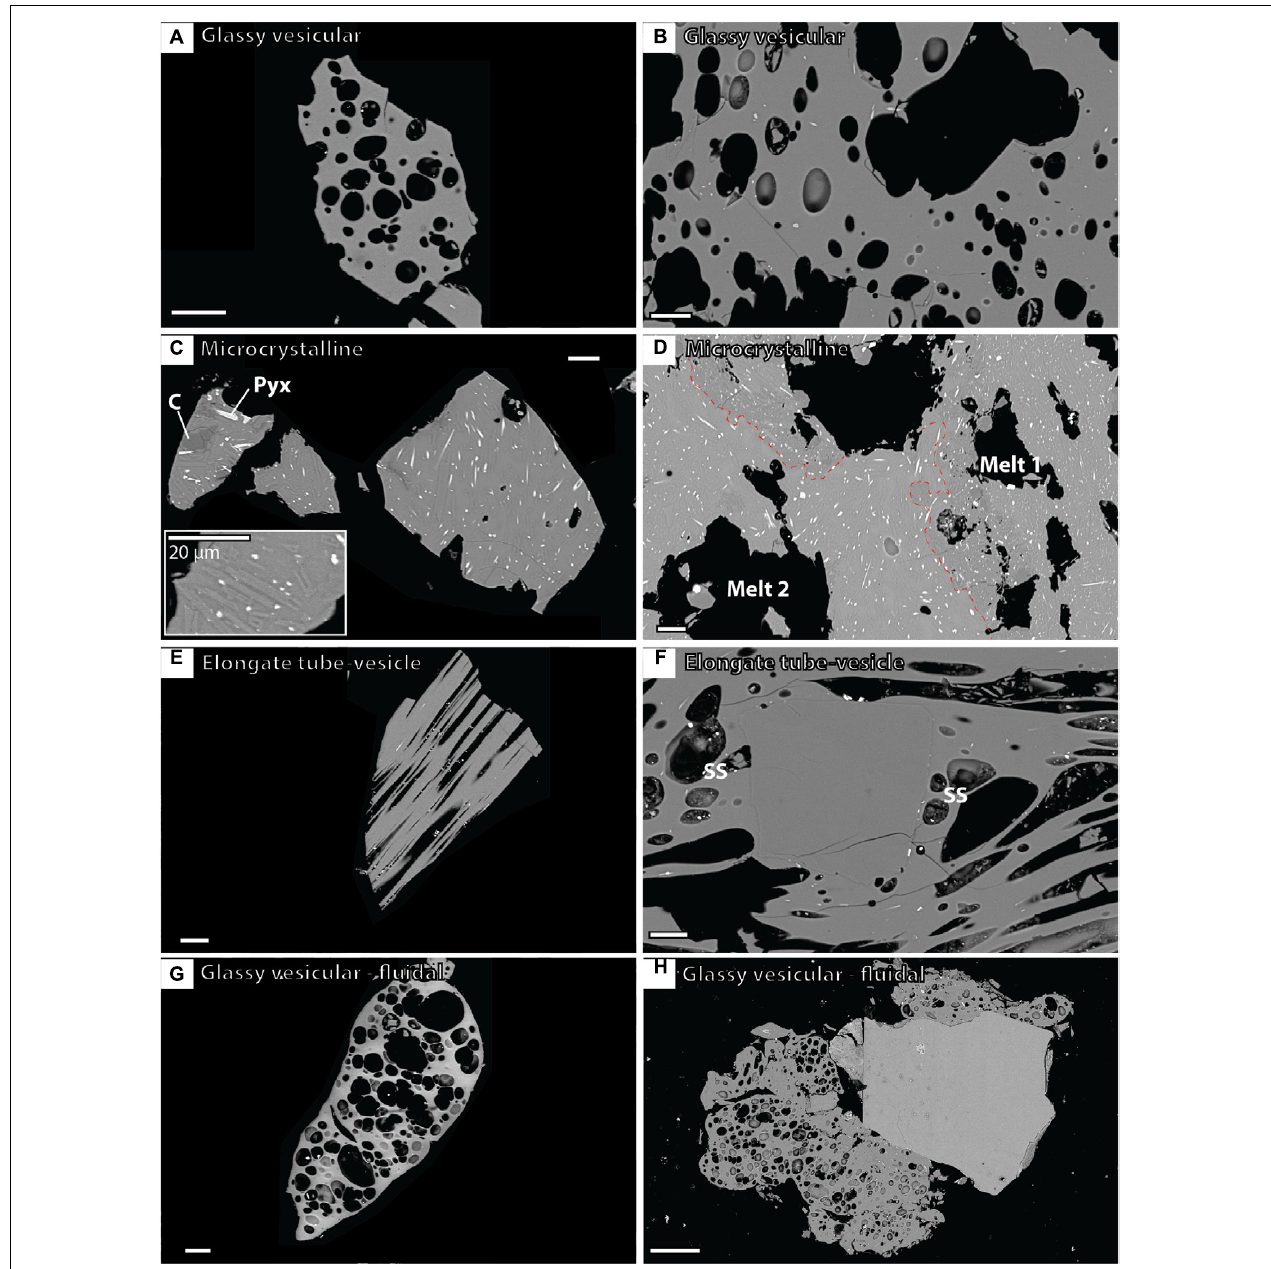
FIGURE 9 | SEM images illustrating representative microtextures of glassy vesicular (a,b) , microcrystalline (c,d) , elongate tube-vesicle (e,f) , and glassy vesicular fluidal (g,h) components (scale bars are 100 µ m unless otherwise noted). Glassy vesicular particles show rounded vesicles and dominantly glassy groundmasses. Microcrystalline particles show a range of both groundmass crystallinity and vesicle textures (c,d) , in (c) three microcrystalline grains can be observed each showing differing crystallinities show plagioclase (Plg) and pyroxene (Pyx) microlites. Groundmass-hosted cristobalite (C) is common (c) , textures of mingling between melt of different crystallinities are rarely observed (d) . Elongate tube-vesicle grains are generally glassy with aligned sheared vesicles and microlites (e,f) . Around phenocrysts strain shadows (SS) can occasionally be observed (f) . The fluidal particles show a Pele’s Tear-like structure with a highly vesicular core and a dense glassy rim (g,h) . In the case of (h) the Pele’s Tear structure appears domainal with several separate vesicular cores and dense rims.